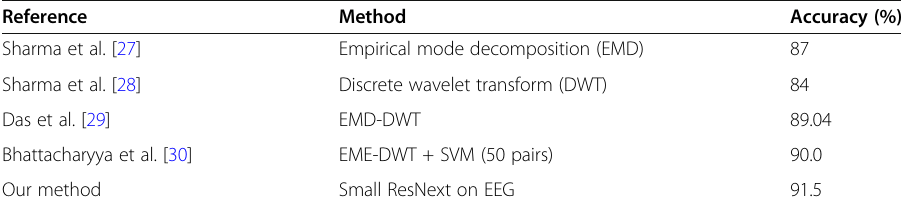
Table 5 Model comparison